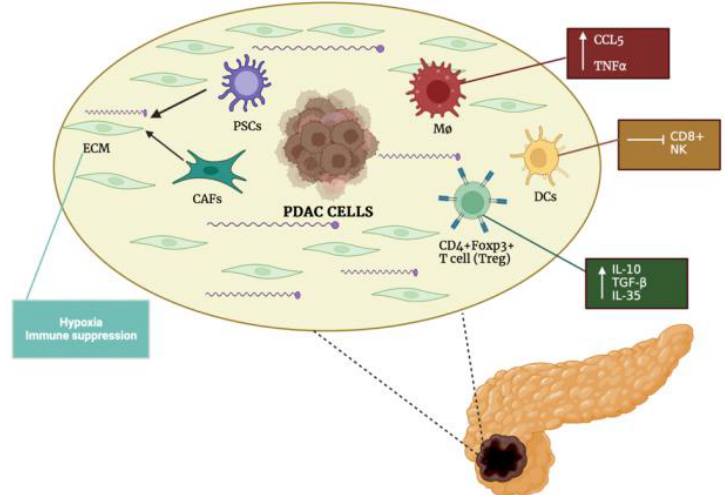
Figure 2. The immune landscape in PDAC. Abbreviations: PDAC, pancreatic ductal adenocarcinoma; CAFs, cancer-associated fibroblasts; PSCs, pancreatic stellate cells; ECM, extra-cellular matrix; CCL5, CC motif chemokine ligand 5; TNFα, tumor necrosis factor alfa; Mø, macrophages; CD4+Foxp3+T cell Treg, regulatory T cell; IL-10, interleukin 10; IL-35, interleukin 35; TGF-β, transforming growth factor beta; DCs, dendritic cells; NK, natural killer.